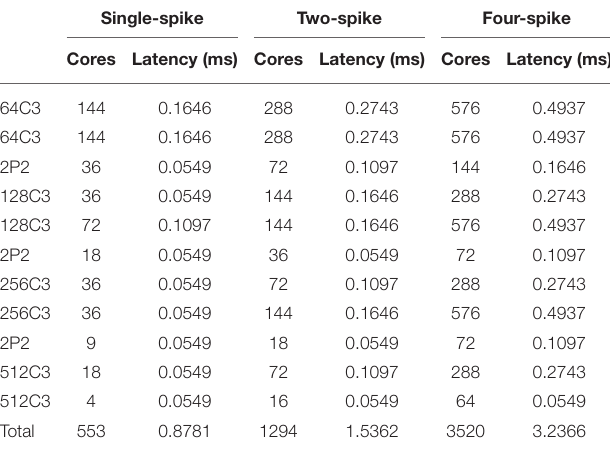
TABLE 9 | Chip utilization and latency for LeNet. Single-spike Two-spike